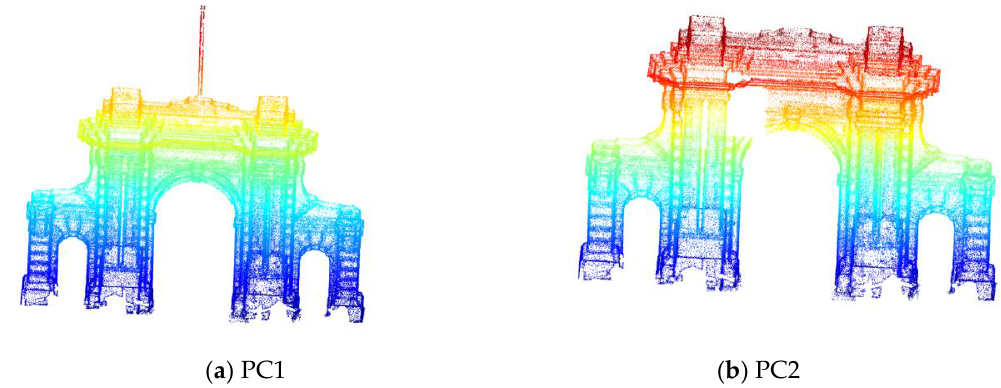
Figure 3. The test data: ( a ) point clouds named PC1 and ( b ) PC2 generated by deleting some points from PC1.